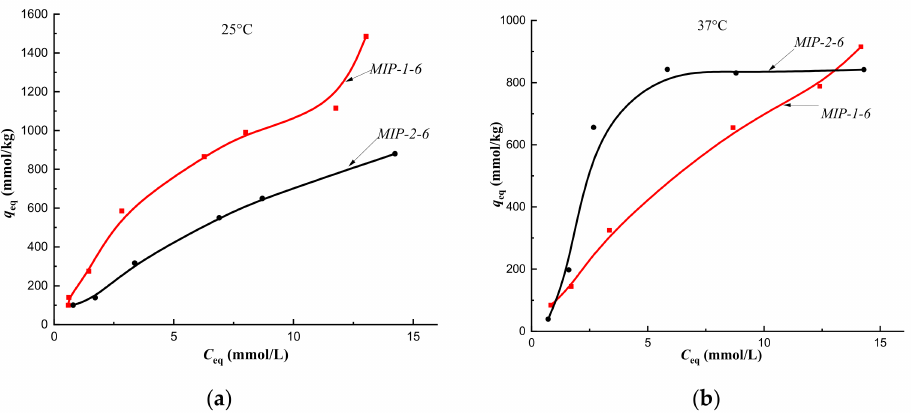
Figure 10. Isotherms of sorption of cholesterol on MIP-1-6 and MIP-2-6 at a temperature of 25 ◦ C ( a ) and at a temperature of 37 ◦ C ( b ) (fraction 160–315 µ